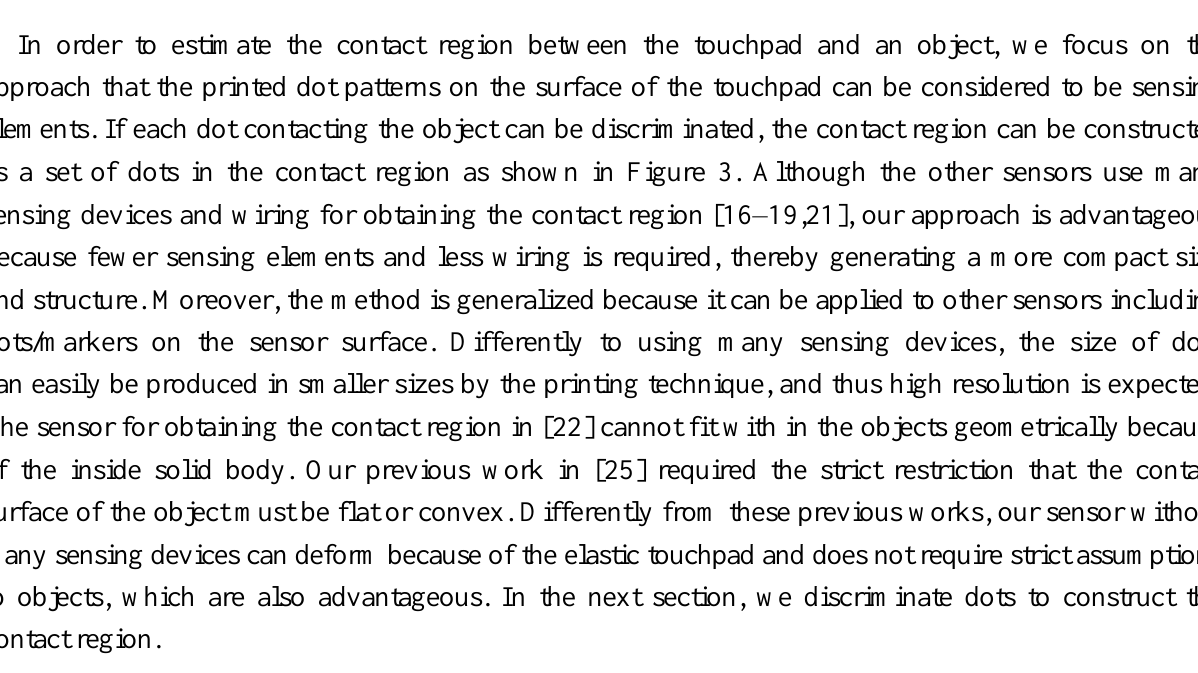
Figure 3. The contact region between the touchpad and an object is constructed as a set of the contacting